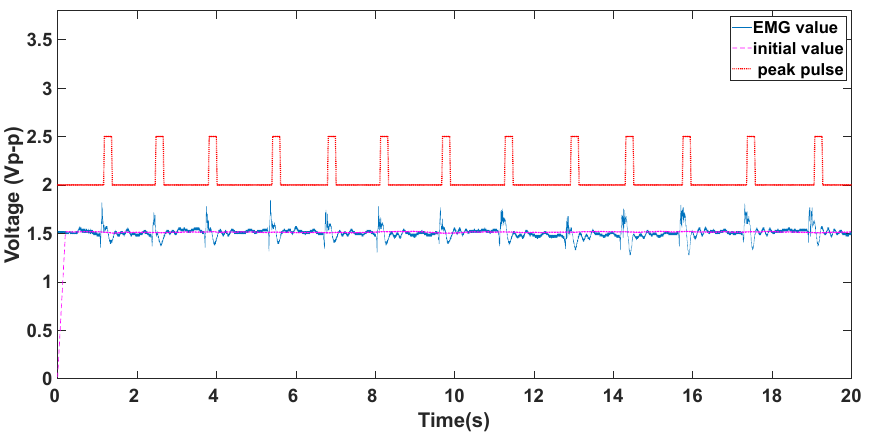
Figure 14. Peak pulse generated with the EMG signal.